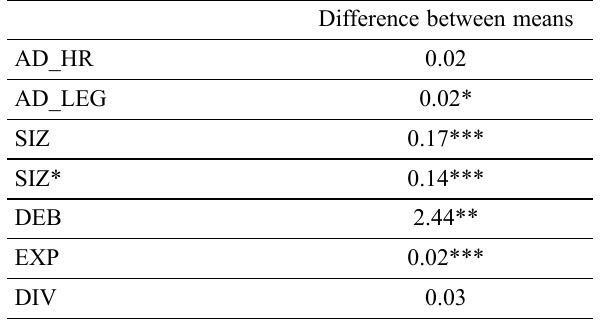
Table 4. Test of equality of means between family and